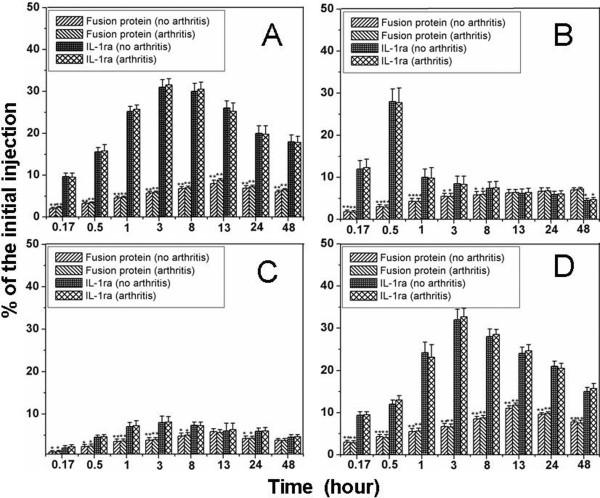
The uptake kinetics of131I-labeled fusion protein and131I-labeled IL-1ra in the liver (A), kidney (B), spleen (C), and lung (D) of mice with (n = 5) and without CIA (n = 5). Data are expressed as mean ± SEM. * = p < 0.05 and ** = p < 0.01 versus uptake rates of 131I-labeled IL-1ra in liver, kidney, spleen, and lung of arthritic mice or healthy mice.